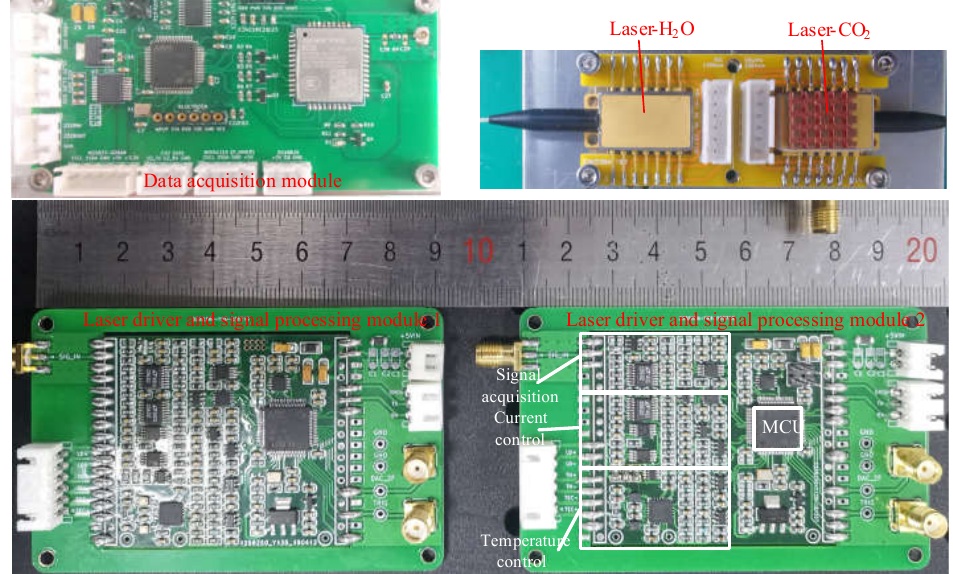
Figure 4. Actual circuit board of the miniaturized TDLAS system.